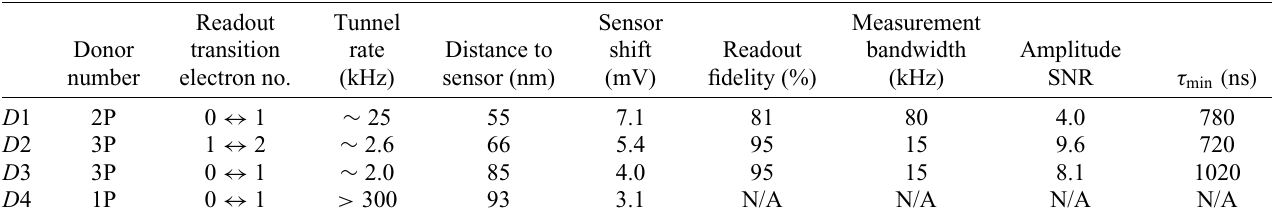
TABLE I. Summary of single-shot readout results for the four-donor-dot device.